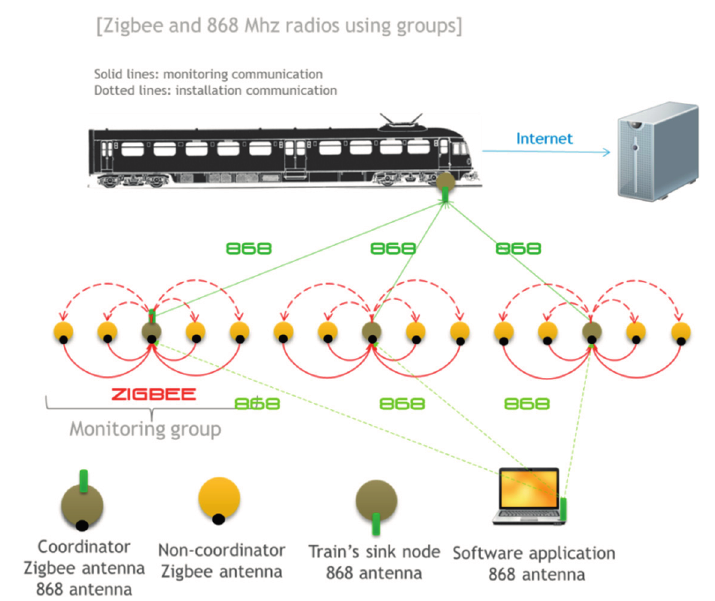
Figure 7. ZigBee and 868 MHz radios using groups: Communication architecture.